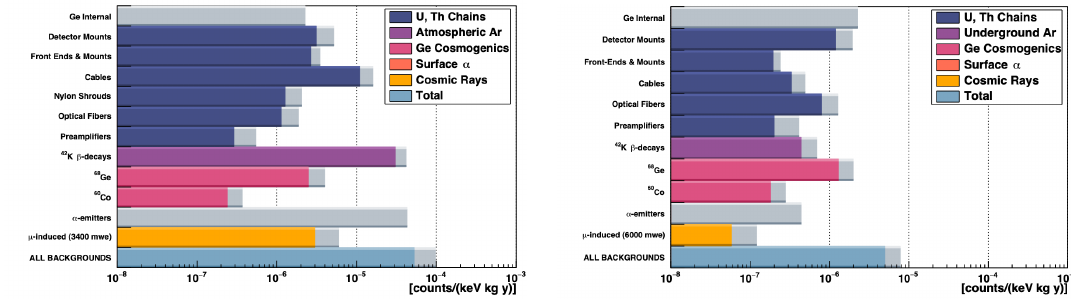
Figure 30. Expected background contributions near Q ββ after all cuts for L EGEND -200 ( left panel ) and L EGEND -1000 ( right panel